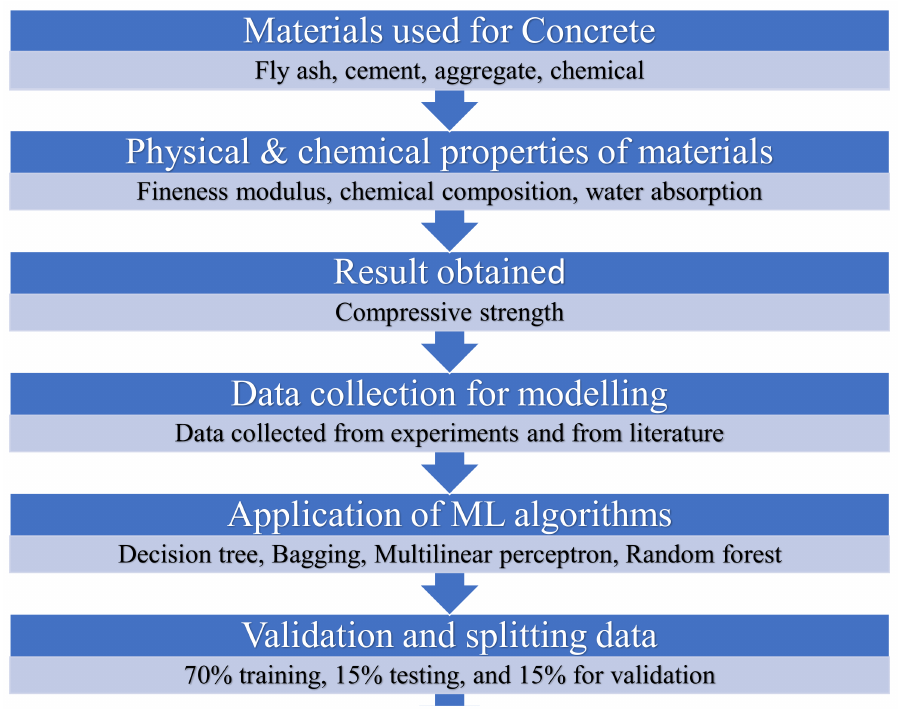
Figure 2. Flow chart of the research program indicating the step-by-step